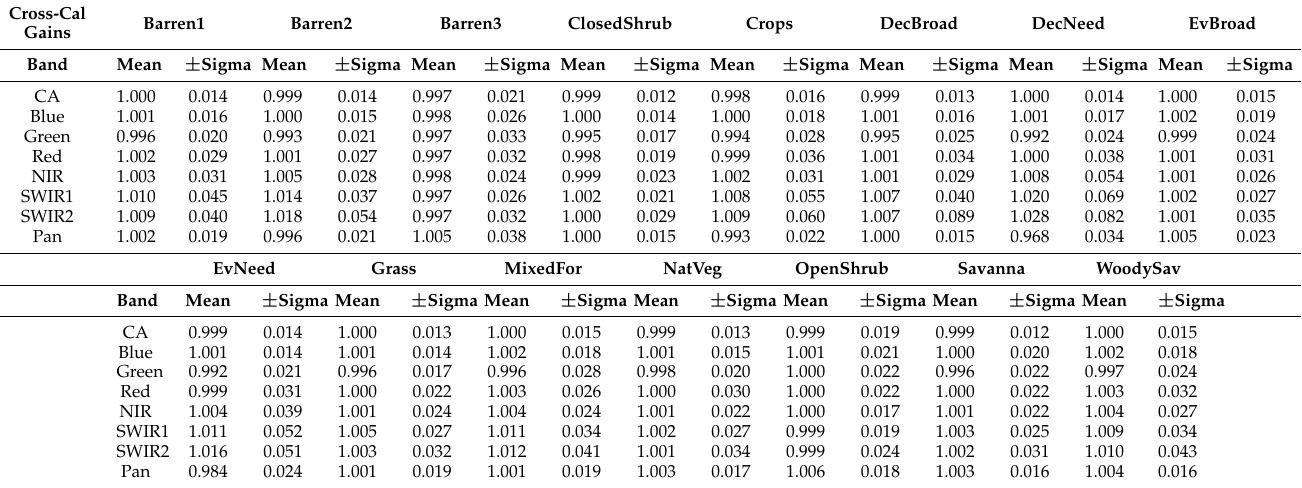
Table 5. Reflectance cross-calibration gain estimates for each IGBP type before SBAF correction.